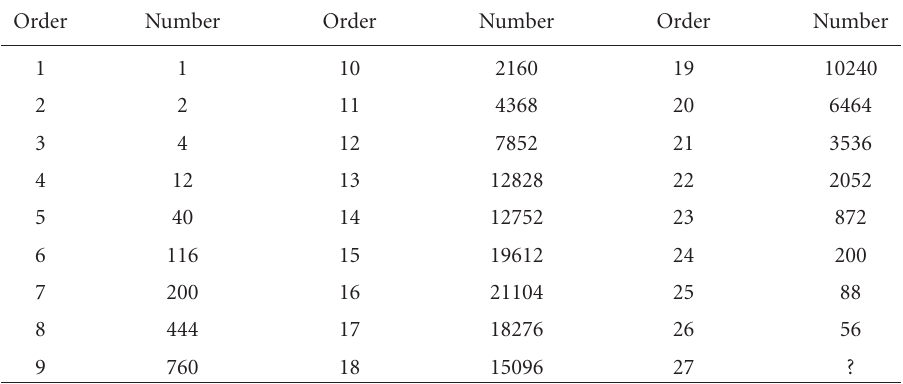
Table 6.1. Number of Costas arrays per order found by exhaustive